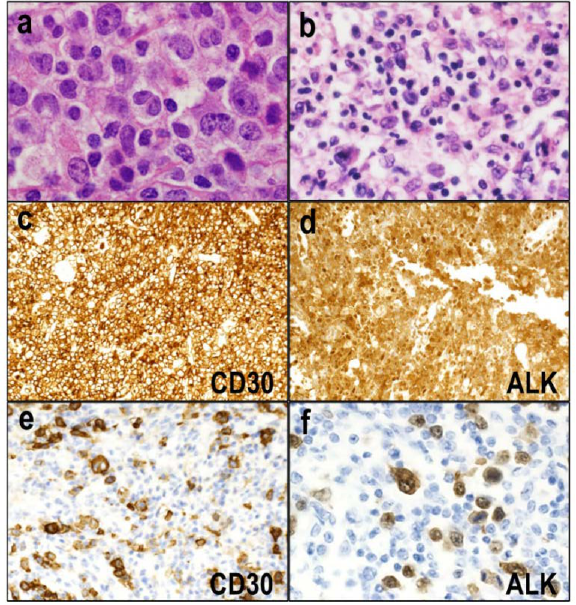
Figure 1. ALK-positive anaplastic large cell lymphoma (ALCL). ( a ) The common pattern shows a sheet-like and cohesive growth pattern of large tumor cells with irregular nuclei, some of which have hallmark cell features (HE 400). ( b ) In the lymphohistiocytic pattern, neoplastic cells are × scattered and admixed with abundant reactive histiocytes and small lymphocytes (HE 400). ( c ) The × common pattern shows diffuse and strong CD30 expression ( 200). ( d ) In all ALK + ALCL cases, × the tumor cells express ALK ( 200). ( e ) The lymphohistiocytic and small-cell patterns may show × heterogenous CD30 expression patterns ( 200). ( f ) ALK immunohistochemistry highlights the tumor × cells of morphologic variants, which may contain scarce hallmark